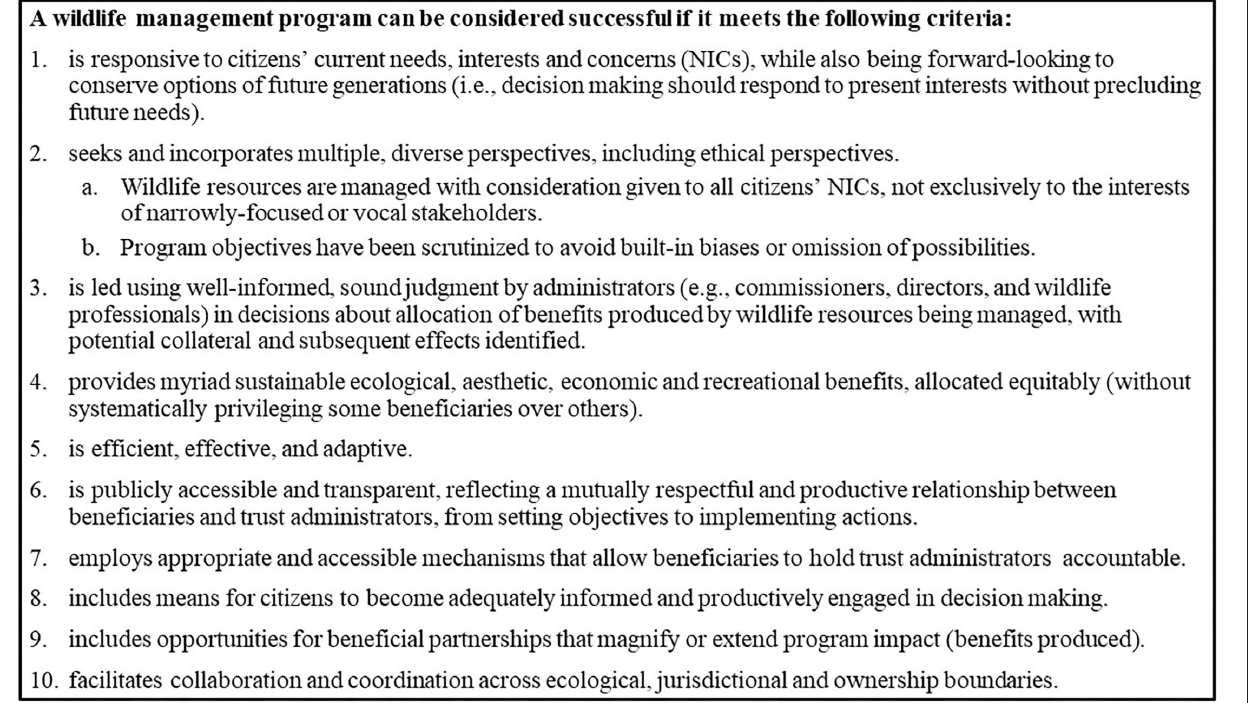
FIGURE 2 | Ten standards for success in wildlife governance in the United States. These standards can help public wildlife managers define, measure, and evaluate success of particular policies and programs. Each standard correlates with one of the ten wildlife governance principles presented by Decker et al.